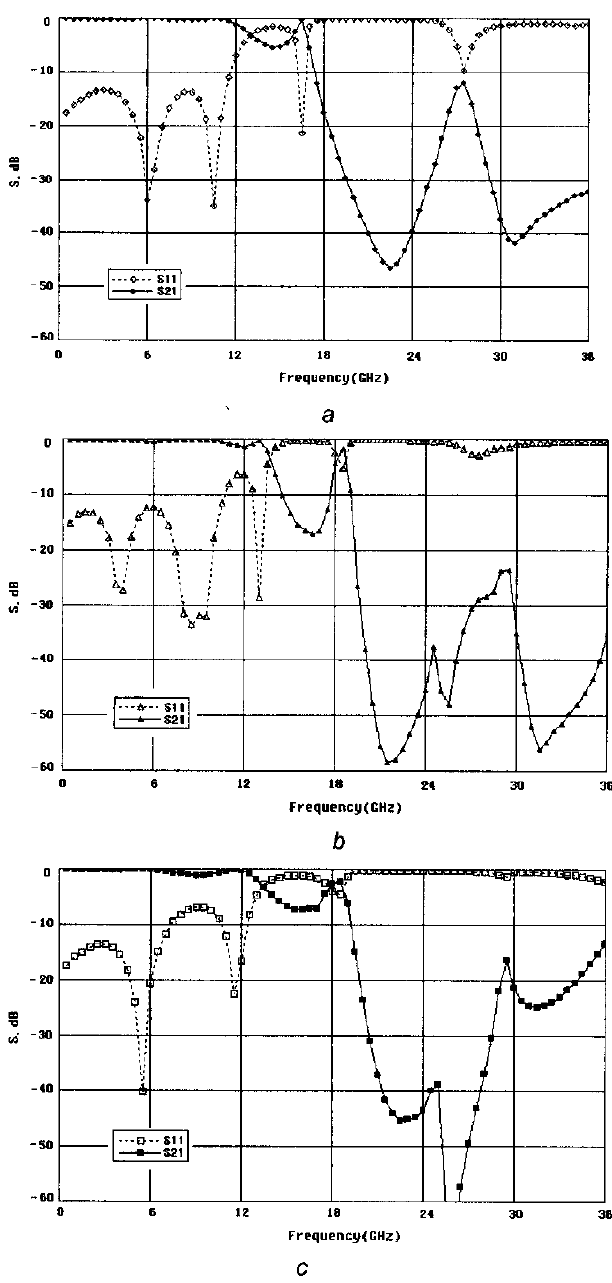
FIGURE 3 Simulated S parameters of the microstrip line with the three